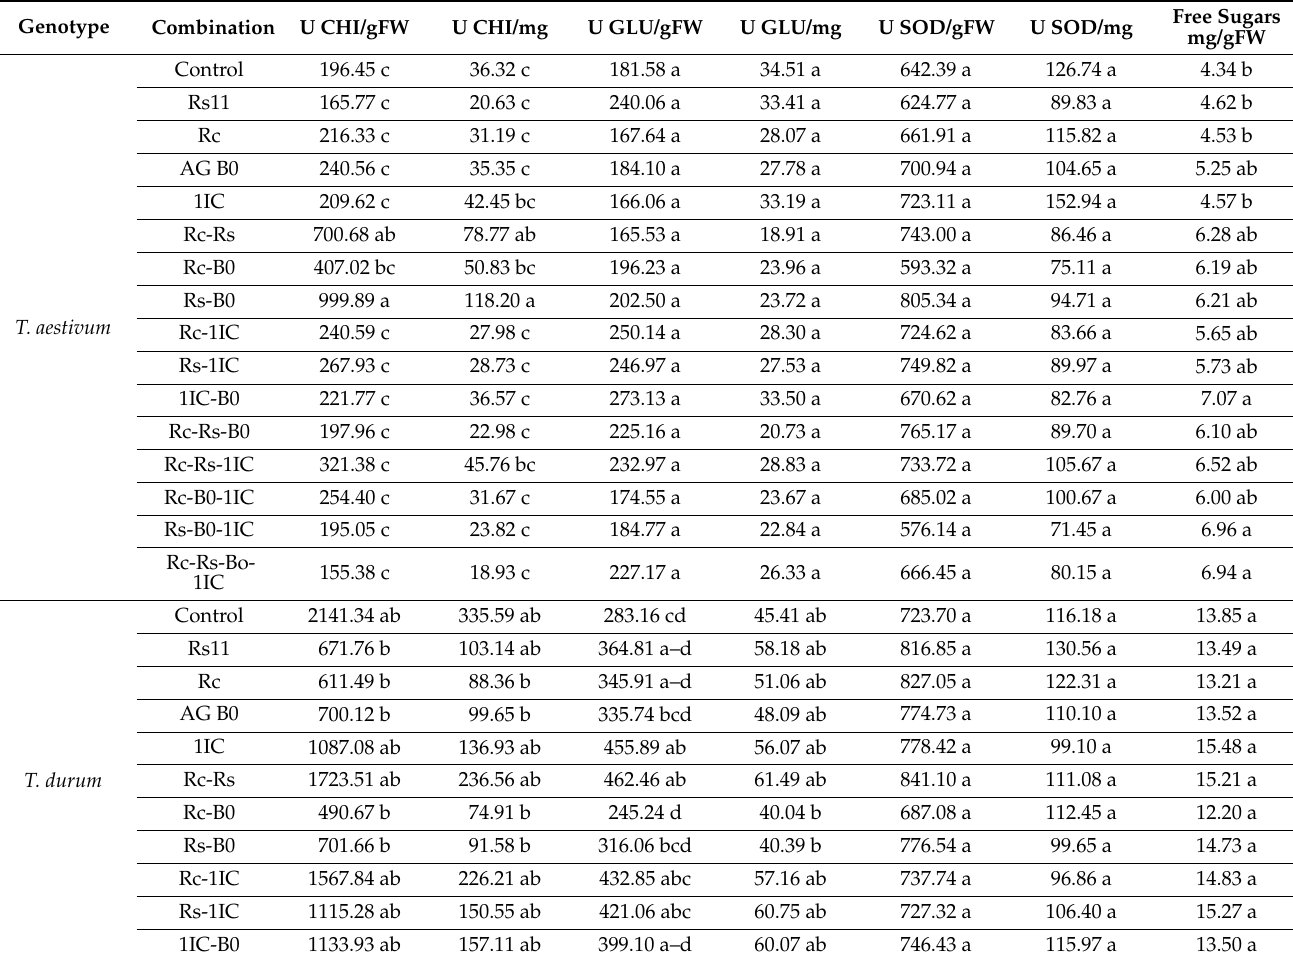
Table 3. One-way Anova results for each plant genotype basic enzymatic and metabolic parameters in experimental combinations. Different letters by the value (mean) indicates a statistical different